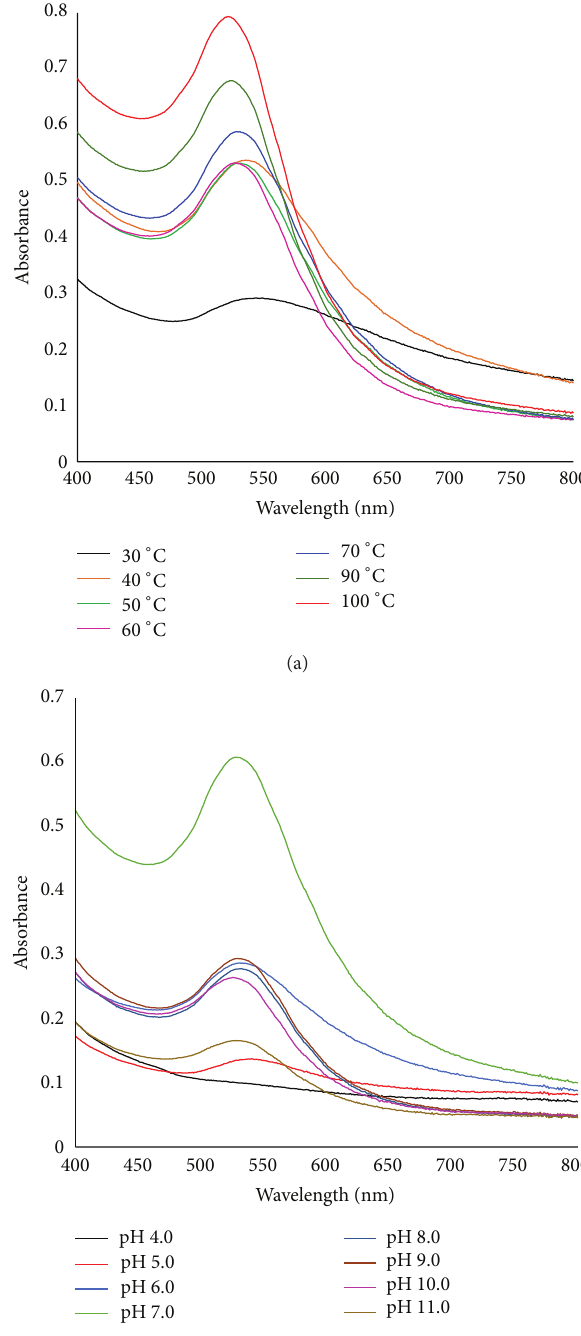
Figure 3: The effects of temperature (a) and pH (b) on synthesis of GNPs by peptide